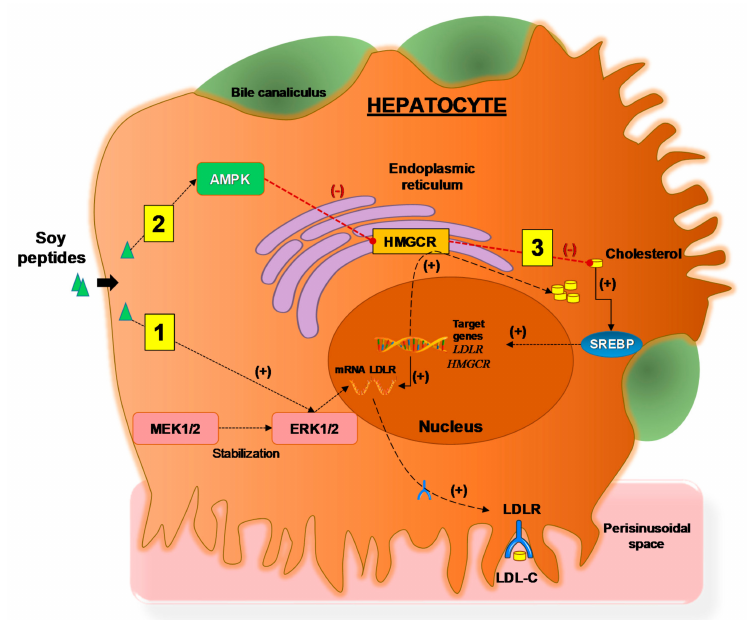
Figure 5. The mechanism of action of soy peptides in HepG2 cells, adapted from Lammi et al., 2015 [63]. Three distinct pathways lead to increased LDLR activity, which can bind and transport extracellular LDL into liver cells with final hypocholesterolemic effects. (1) Soy peptides, which enter the pathway that stabilizes mRNA levels contributing to the increased levels of LDLR protein in the plasma membrane and increased LDL-C uptake. (2) Soy peptides activate AMPK which, by phosphorylation inactivates the target substrate HMGCR, the key enzyme involved in cholesterol synthesis. This step is associated with decreased intracellular level of cholesterol. (3) Decreased intracellular cholesterol levels activate the transcription factor SREBP-2 which, in turn, activates the transcription of genes LDLR and HMGCR resulting in increased levels of proteins LDLR and HMGCR, respectively. Abbreviations: AMPK, adenosine monophospate-activated protein kinase; ERK1/2, extracellular signal-regulated protein kinases 1 and 2; HMGCR, 3-hydroxy-3-methylglutaryl coenzyme A reductase; LDL-C, low-density lipoprotein-cholesterol; LDLR, low-density lipoprotein receptor; MEK1/2, mitogen-activated protein kinases 1 and 2; SREBP, Sterol regulatory element-binding protein. (+), increased effect; ( − ), decreased